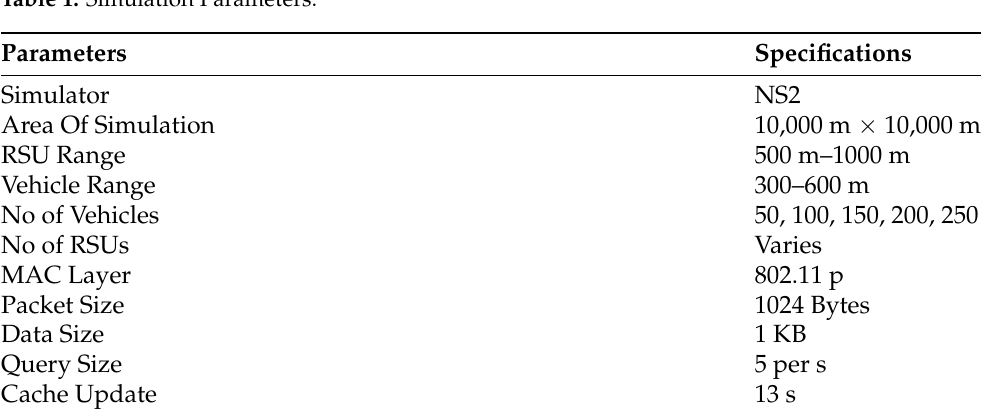
Table 1. Simulation